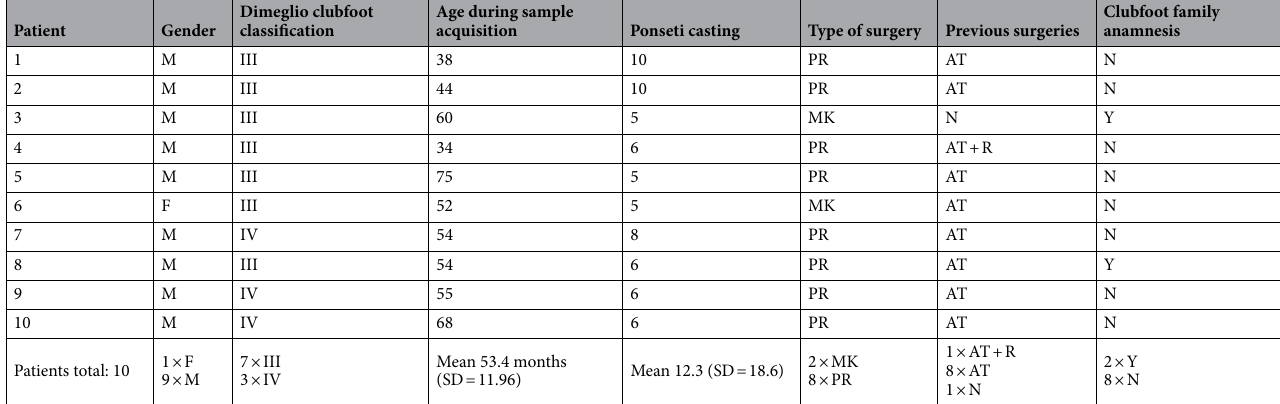
Table 1. Detailed data of 10 patients (sample donors) with a relapse of idiopathic congenital clubfoot. The parents of these patients were generally non-compliant with the Ponseti regime, or were unable to maintain proper treatment by applying an abduction bar, or even failed to come to scheduled examinations. M male, F female, AT achilles tendon tenotomy, AT + R achilles tendon tenotomy + retenotomy, MK McKay, PR posteromedial release, N no, Y